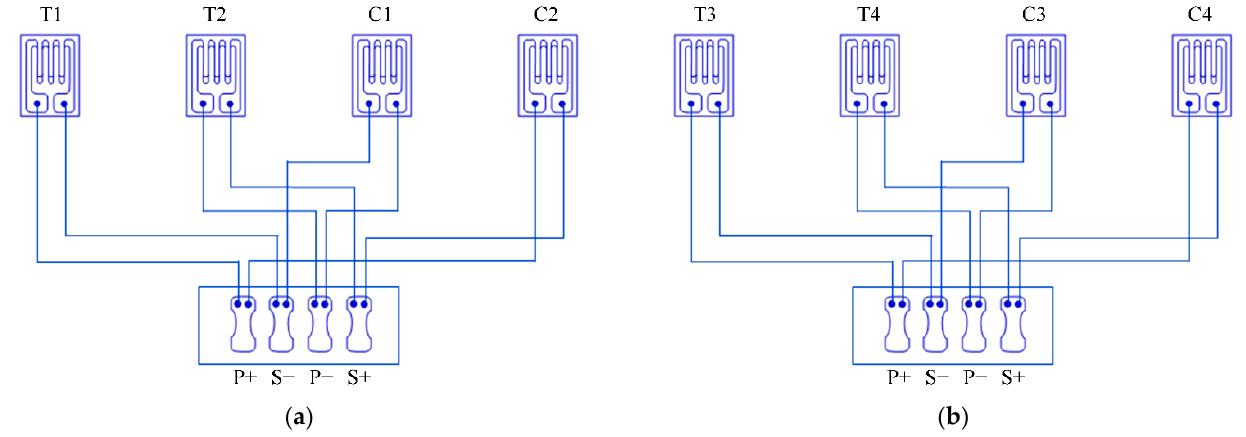
Figure 4. Schematic diagram of measuring bridge: ( a ) In X direction; ( b ) In Y direction.